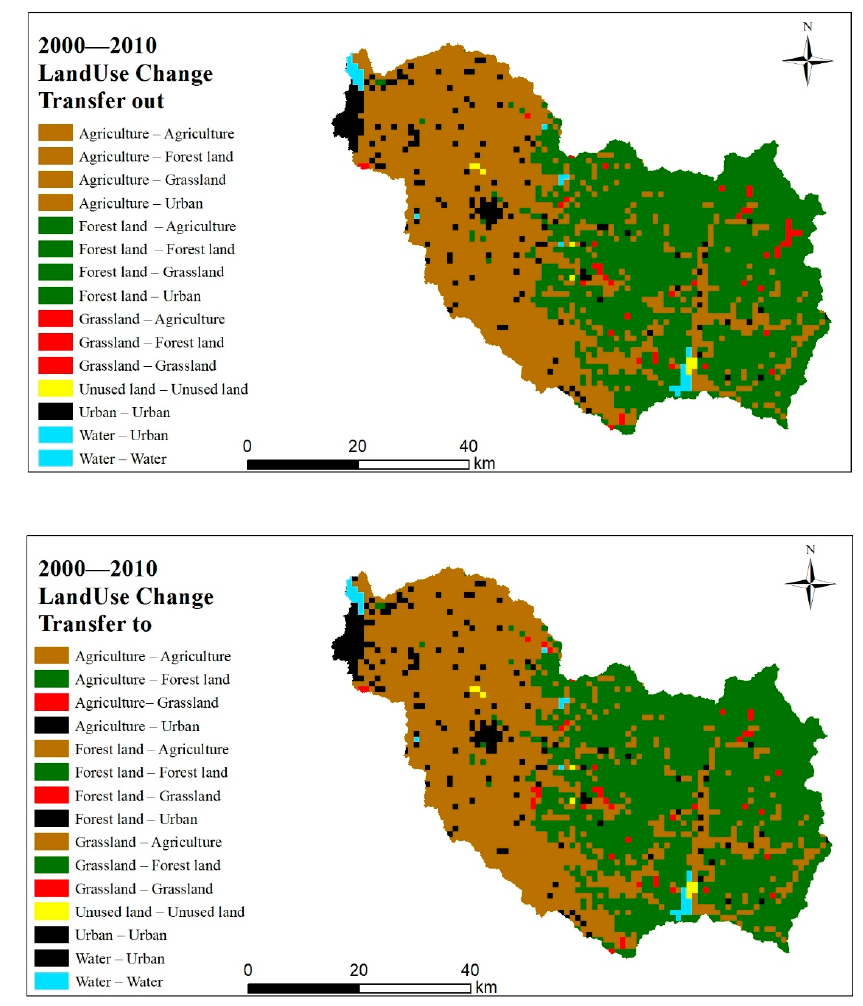
Figure 11. Land use change, 2000–2010. (We can compare by transfer in and transfer out, a certain kind of land transferred out will become a different land use type in the transfer in. The change in this figure is small, but the change in the later Figures 12 and 13 is obvious.)